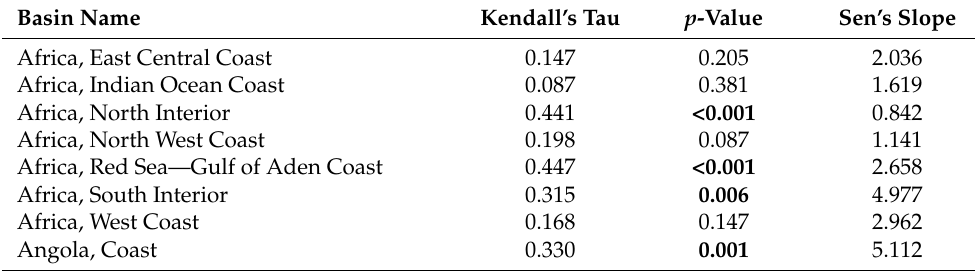
Table 3. Kendall’s Tau, p -value, and Sen’s slope for annual rainfall (1983–2020) for major African river basins. Bold numbers in p -values represent the statistically significant